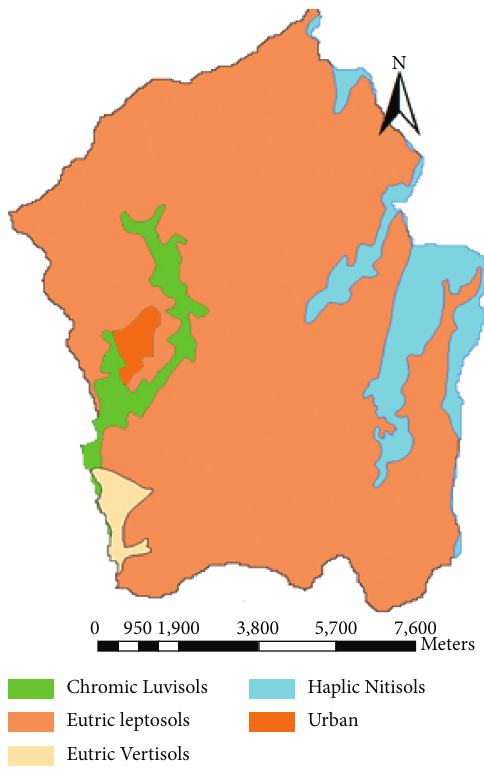
Figure 2: Land use map of the study area. Figure 3: Soil map of Megech dam